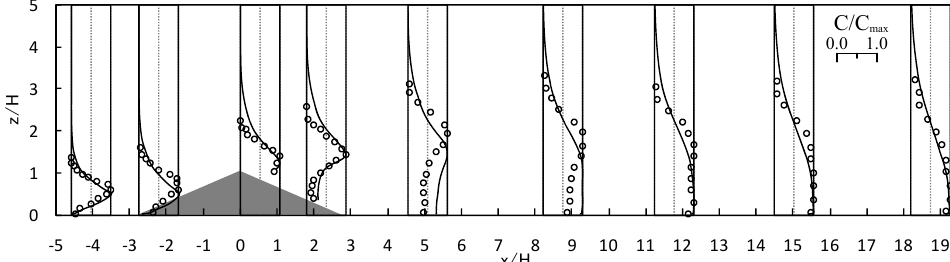
Fig. 7. Streamwise variation of vertical profiles of mean concentration. Figure 7. Streamwise variation of vertical profiles of mean concentration.